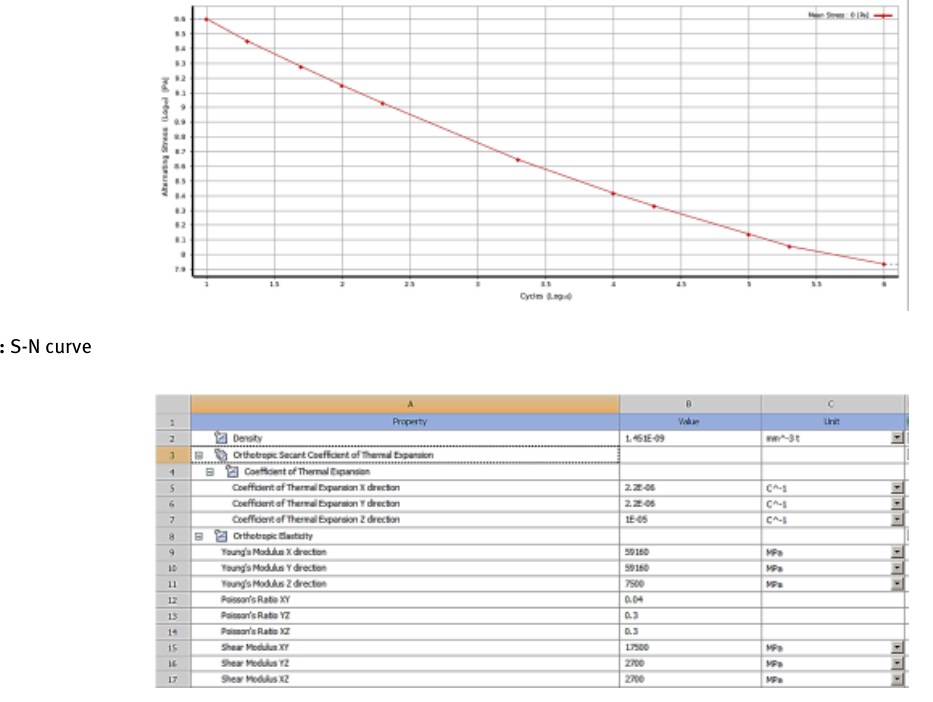
Figure 4: Mechanical properties of carbon fiber